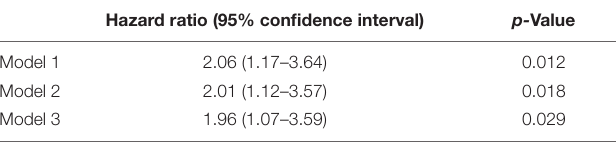
TABLE 4 | Hazard ratio of transition from robust to dynapenia in participants with high risk